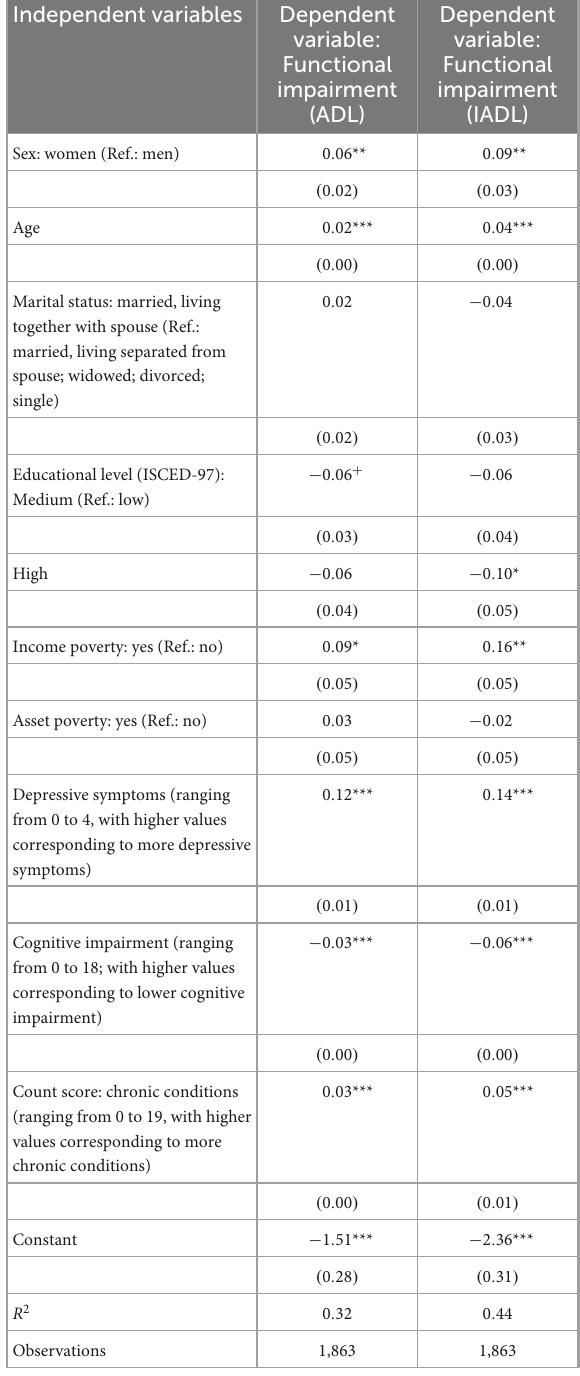
TABLE 2 Determinants of functional